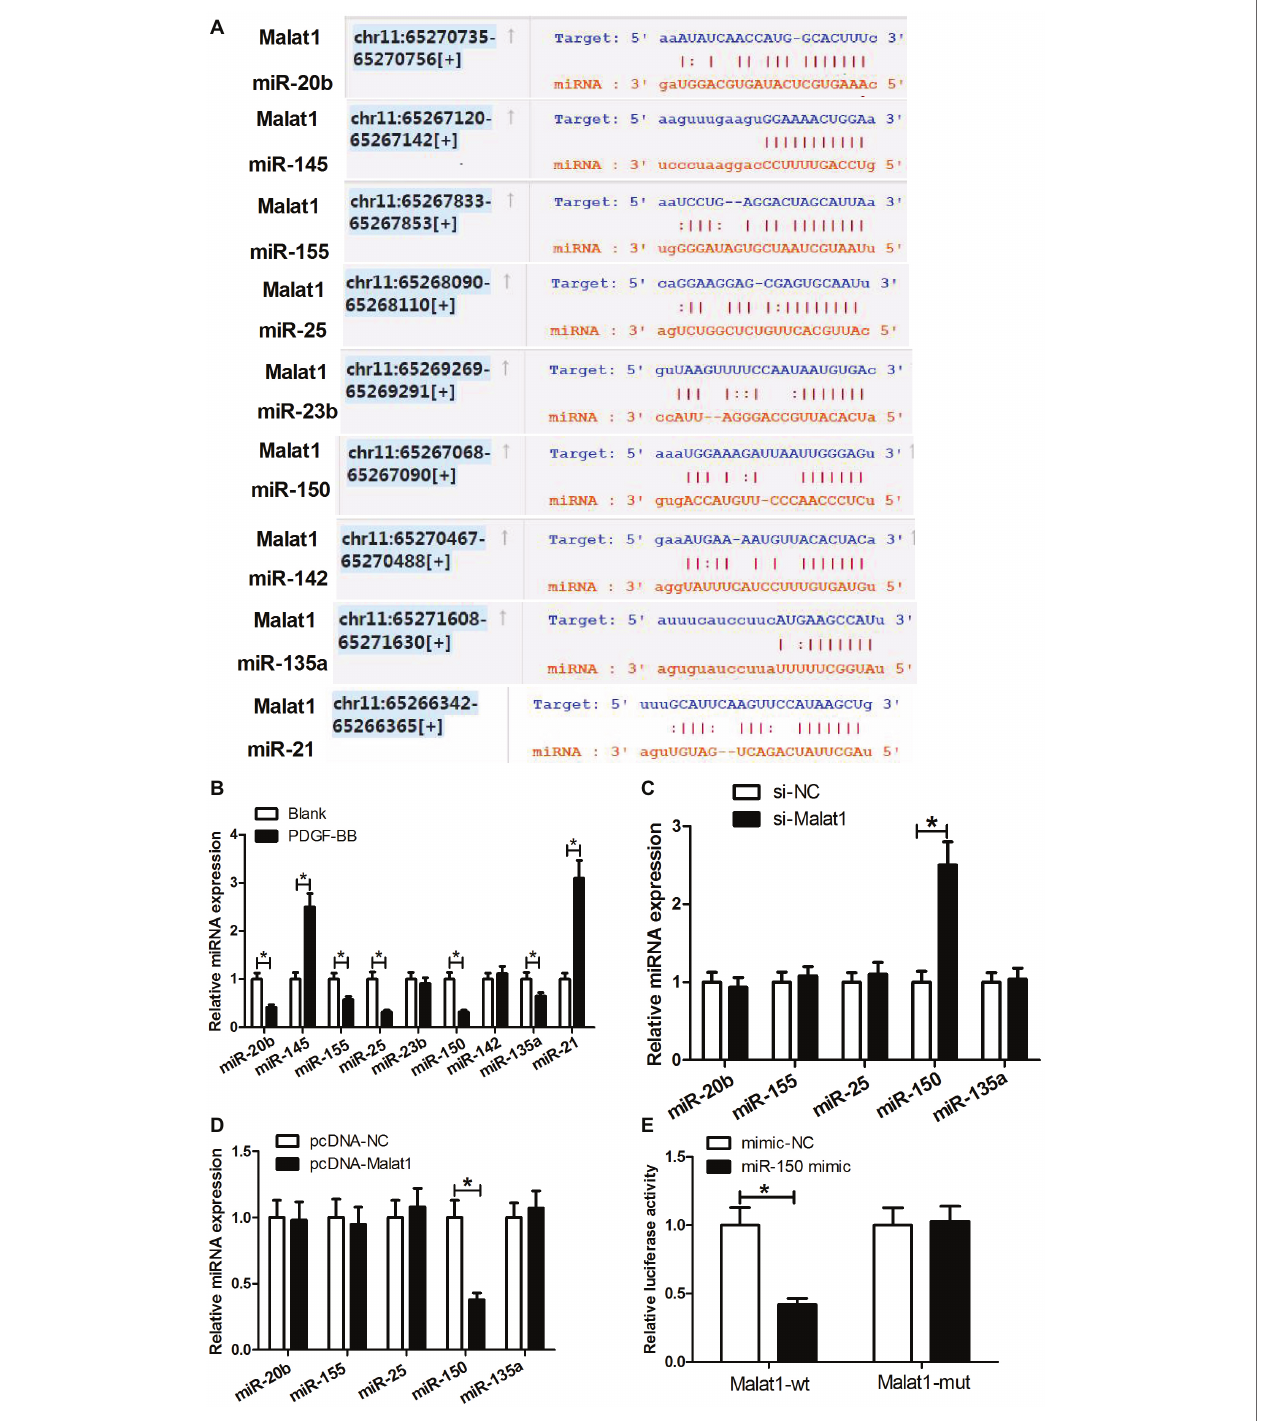
FIGURE 2 | miR-150 is a target of Malat1. (A) Diagram of the putative binding sites of miR-20b, miR-145, miR-155, miR-25, miR-23b, miR-150, miR-142, miR-135a, and miR-21 in Malat1 sequences. (B) The effect of PDGF-BB stimulation on miR-20b, miR-145, miR-155, miR-25, miR-23b, miR-150, miR-142, miR-135a, and miR-21 expression in ASMCs determined by qRT-PCR. (C,D) The effect of Malat1 knockdown or overexpression on miR-20b, miR-155, miR-25, miR-150, and miR-135a expression in PDGF-BB-treated ASMCs determined by RT-PCR. (E) Luciferase reporter assays show that miR-150 mimic transfection significantly suppresses the luciferase activity of reporter vector containing Malat1-wt compared with the mimic-NC transfection, and has no influence on the luciferase activity of reporter vector containing Malat1-mut. * p <